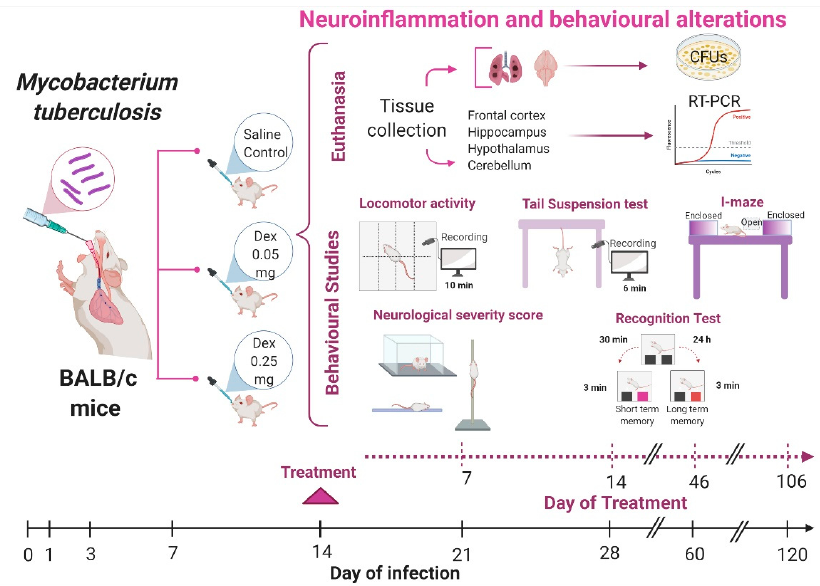
Figure 11. Study design workflow to evaluate the IN DEX treatment on neuroinflammation and behavioral alterations of TB mice. BALB/c mice, 8 weeks of age, were infected with 2.5 × 10 5 live bacilli. On day 14, the treatment with IN DEX started. We used the L/DEX (0.05 mg/kg BW) and M/DEX (0.25 mg/kg BW) by IN route; a control group received saline solution. On days 21, 28, 60, and 120 post-infection, different behavioral tests were made. After the behavioral tests, animals were euthanized, and the brain and lungs were collected to determine bacillary loads. The hypothalamus, hippocampus, cerebellum, and frontal cortex were used to determine cytokines gene expression. For each of the measurements, two independent experiments were performed with n = 3 each. The samples for each experimental age group were run separately. (Created with BioRender.com, accessed on 20 May